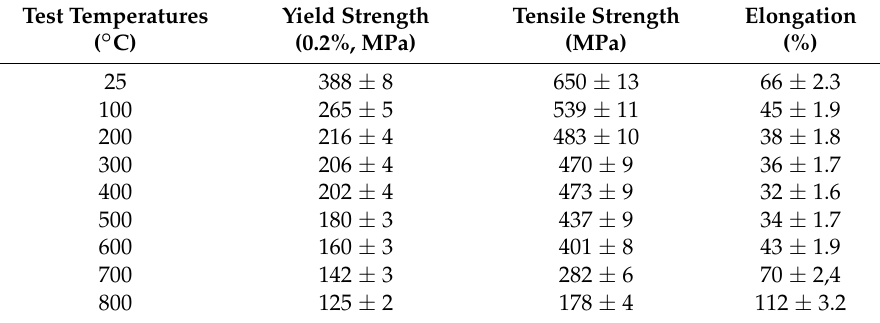
Table 3. Mechanical properties of as-received blanks tested at temperatures of 200–800 °C.